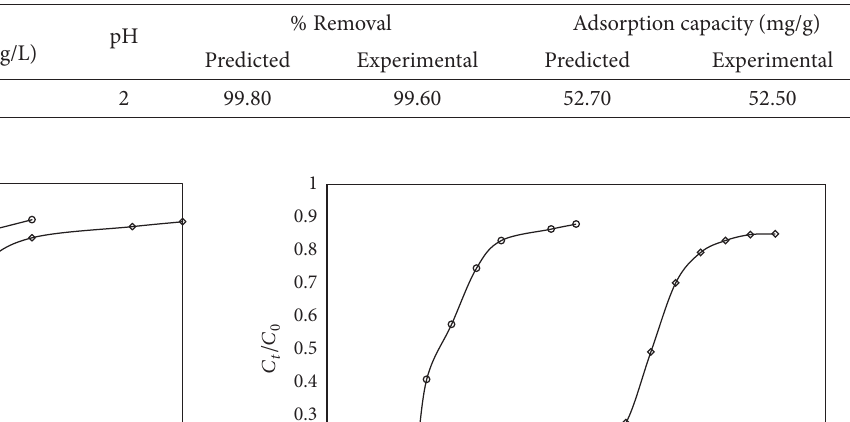
T 7: Optimized process variables value for adsorption of Cr(VI) ions by EAM-CCRCBs.